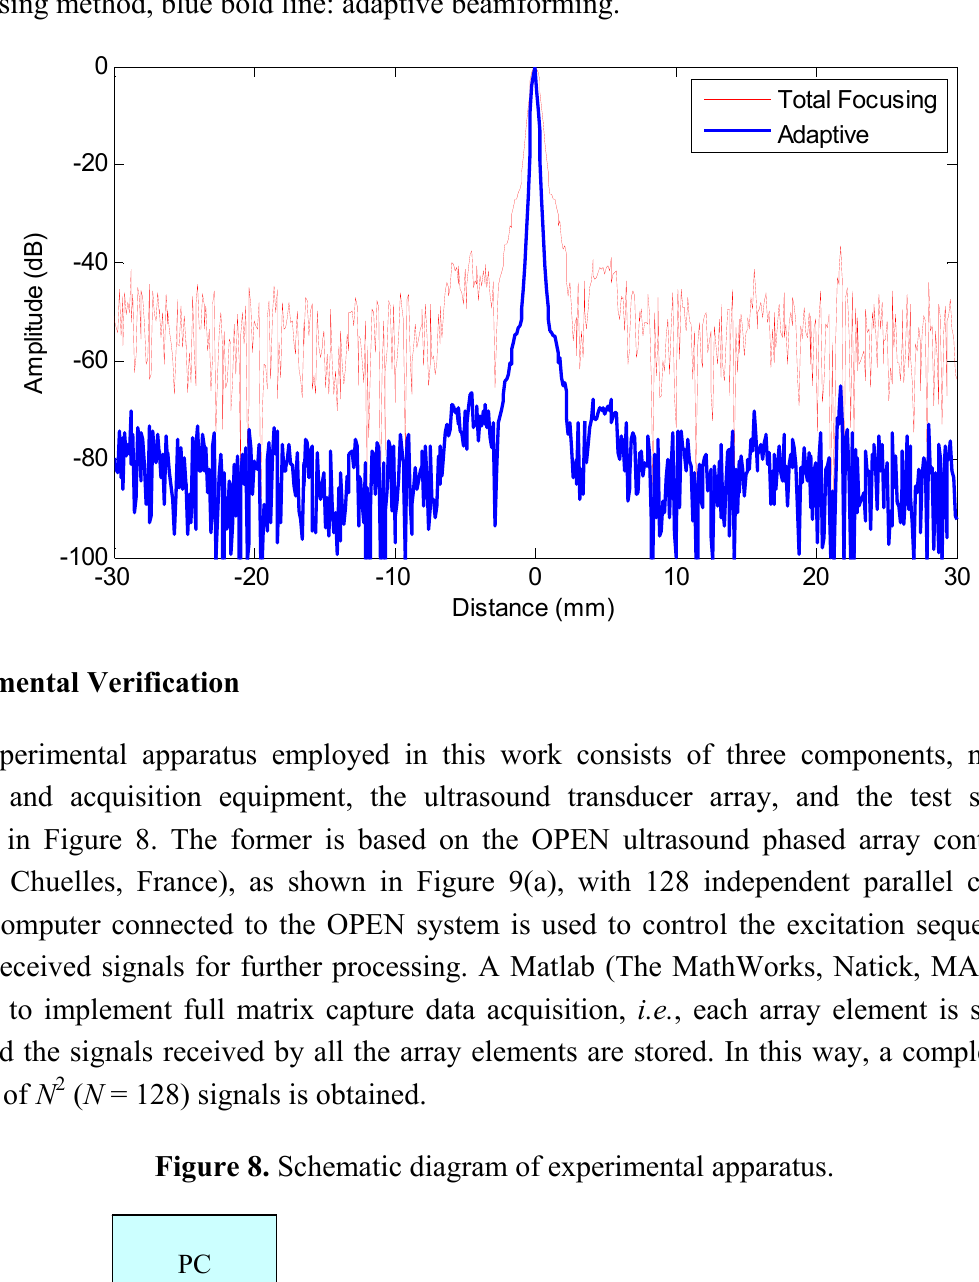
Figure 7. Lateral profiles of simulated images at range of 30 mm. Red solid line: total focusing method, blue bold line: adaptive beamforming.